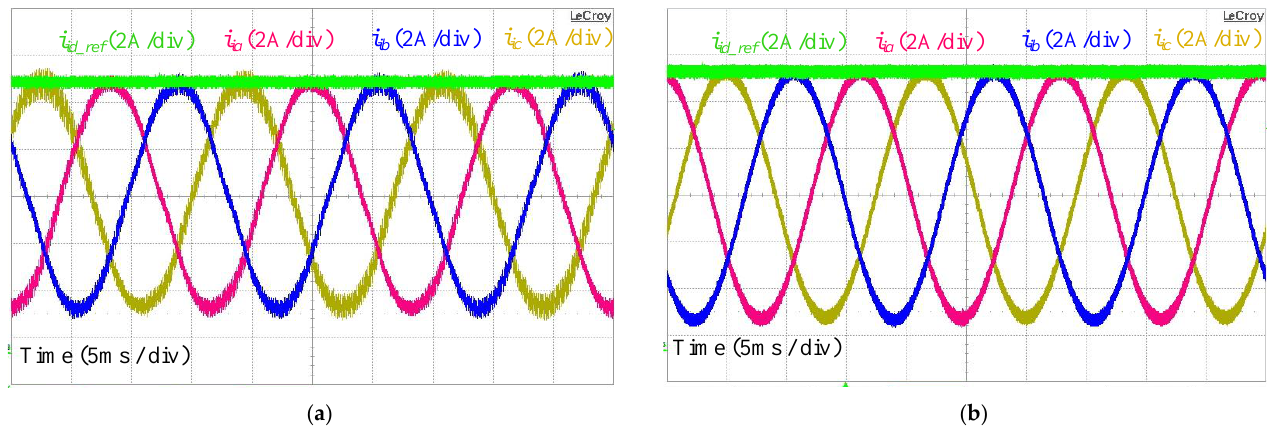
Figure 23. Three-phase inverter side current with C fk = 0.5 μF ( a ) Single-loop PI control; ( b ) RESO-based ADRC.